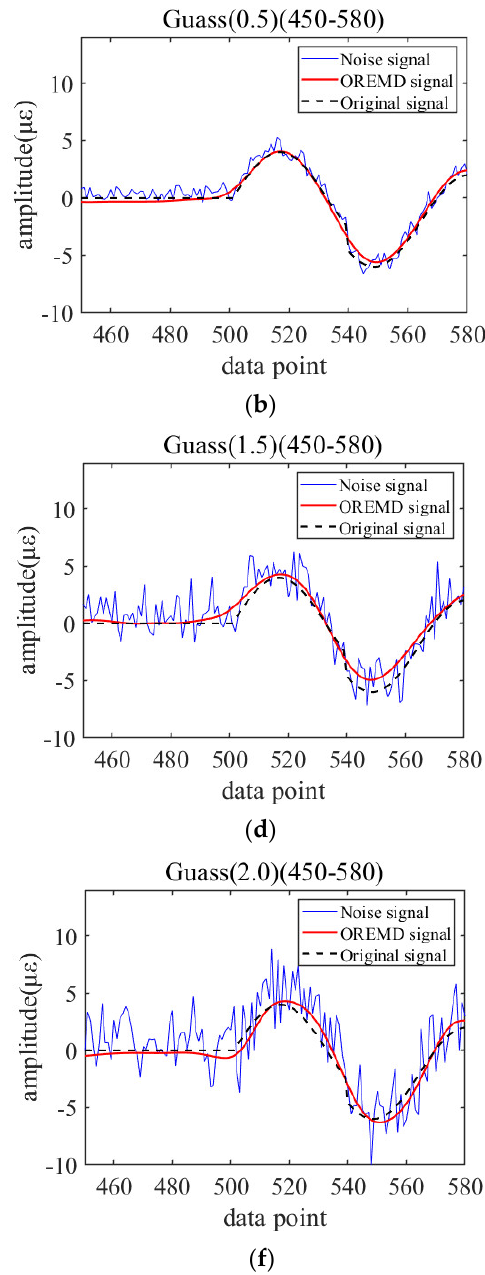
Figure 8. Signal sifting results: ( a , b ) OREMD. ( c , d ) Median filtering. ( e , f ) Traditional EMD. The MSE of OREMD is 0.2015. The median filter width is taken as M = 18, and the optimal MSE is 0.3183. The MES of traditional EMD is 0.6599. The sieving error using the